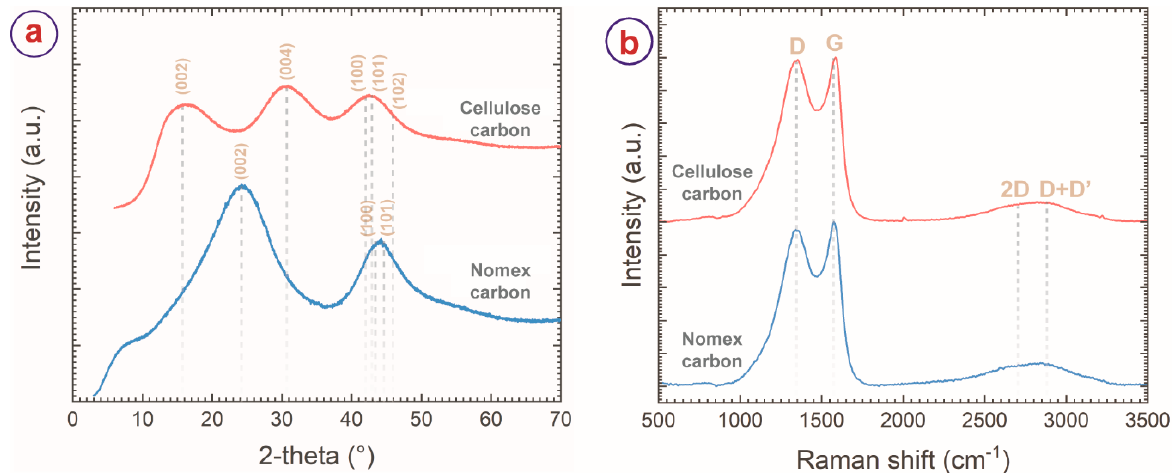
Figure 3. ( a ) XRD diffractograms and ( b ) Raman spectra of cellulose and Nomex-derived carbon sheets, suggesting turbostratic microstructure for both the materials, with a higher degree of crystallinity for Nomex-derived carbon material.